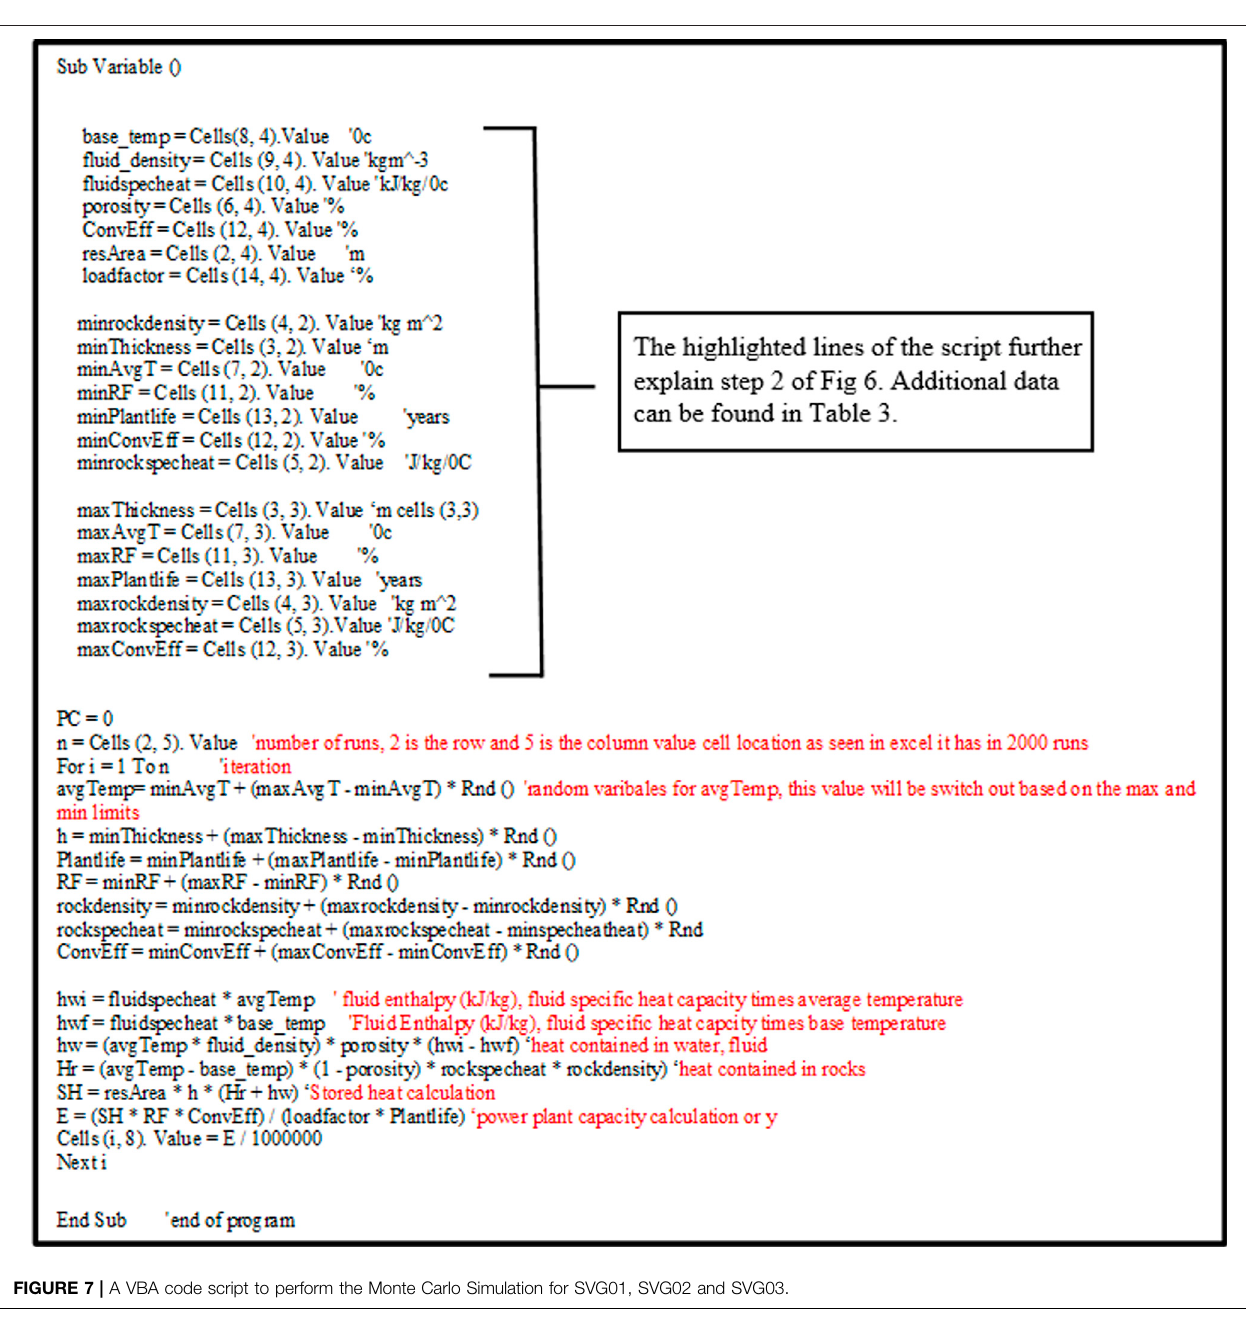
FIGURE 7 | A VBA code script to perform the Monte Carlo Simulation for SVG01, SVG02 and SVG03.